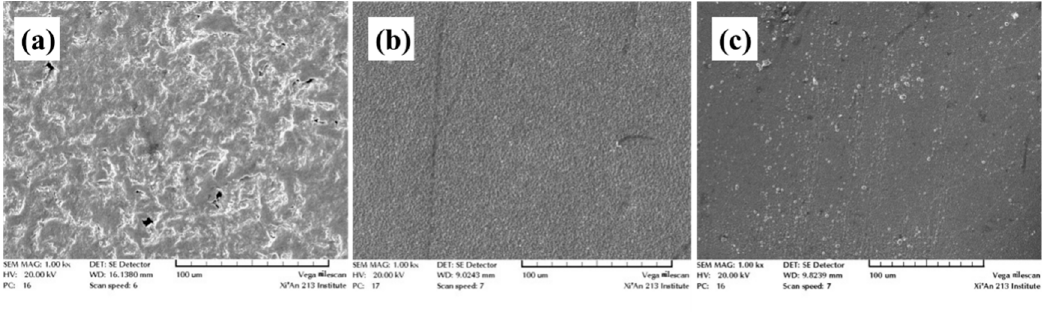
Figure 2. SEM images of Cu foil. ( a ) Sample A, ( b ) Sample B, and ( c ) Sample